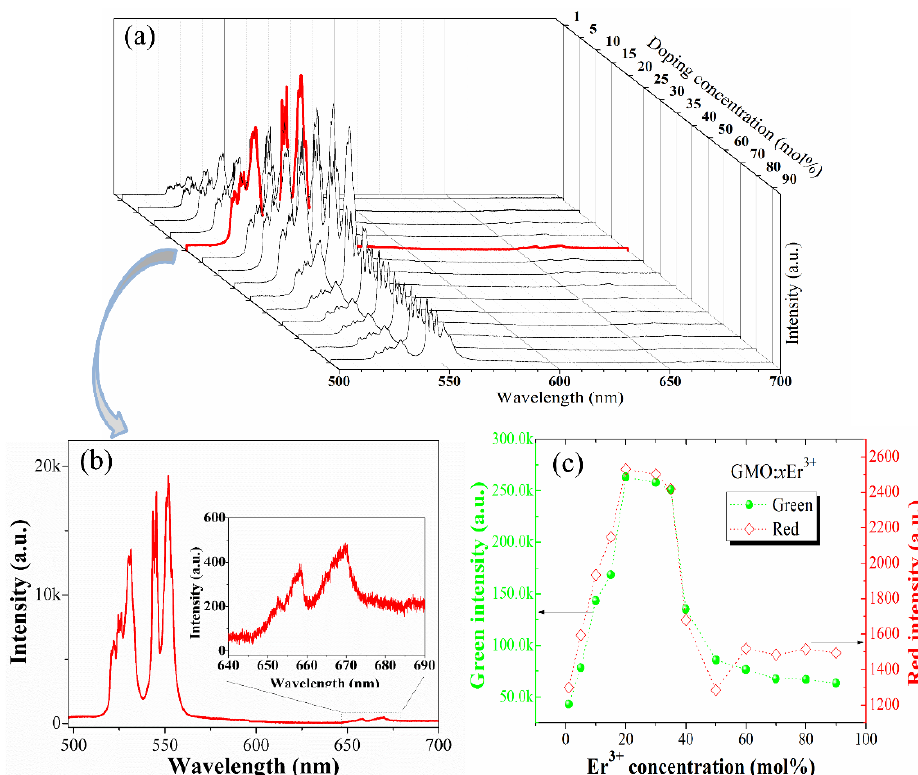
Figure 2. Upconversion emission spectra of Gd 2 (MoO 4 ) 3 : x Er 3+ phosphors ( a ). Upconversion emission spectrum of Gd 2 (MoO 4 ) 3 :20Er 3+ phosphor; inset: the red emission band ( b ). The intensities of green emission (left) and red emission (right) as a function of Er 3+ concentration in Gd 2 (MoO 4 ) 3 : x Er 3+ phosphors ( c ).